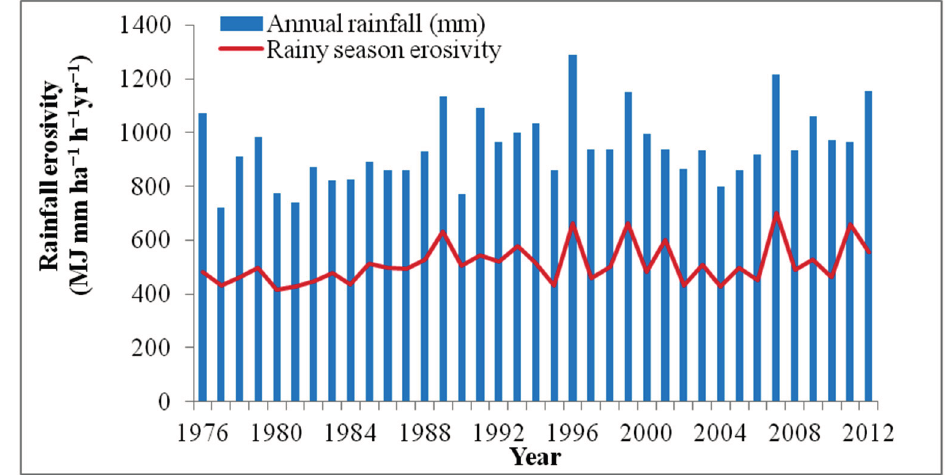
Figure 5. Rainfall erosivity.